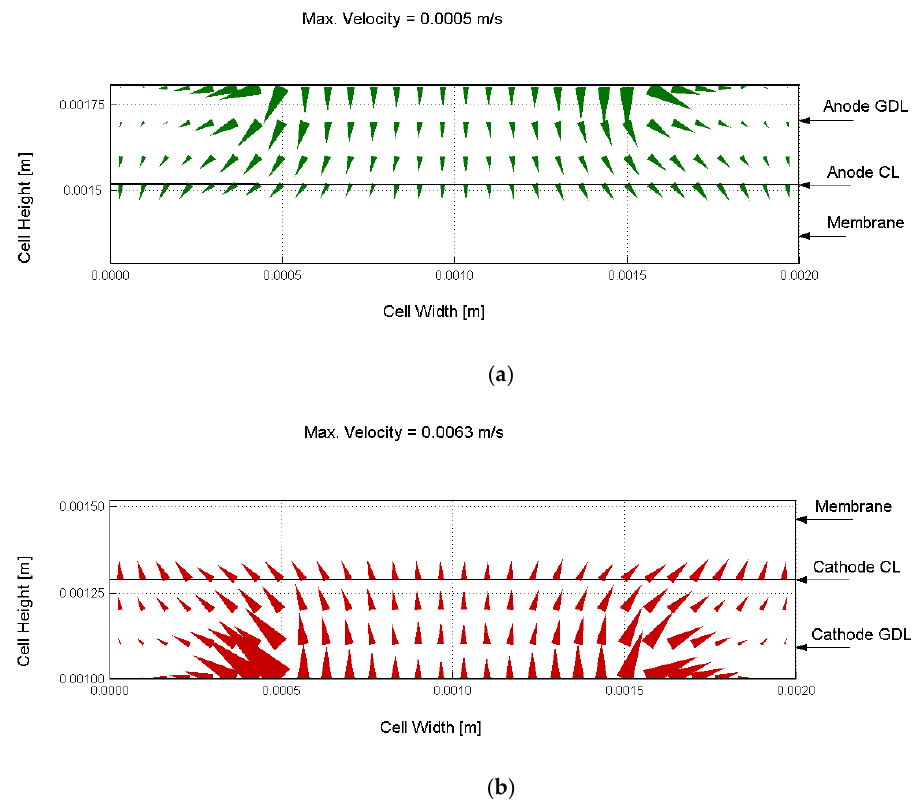
Figure 10. Velocity profiles of: ( a ) the anode GDL and cathode GDL, and ( b ) the y-z plane at x = 25